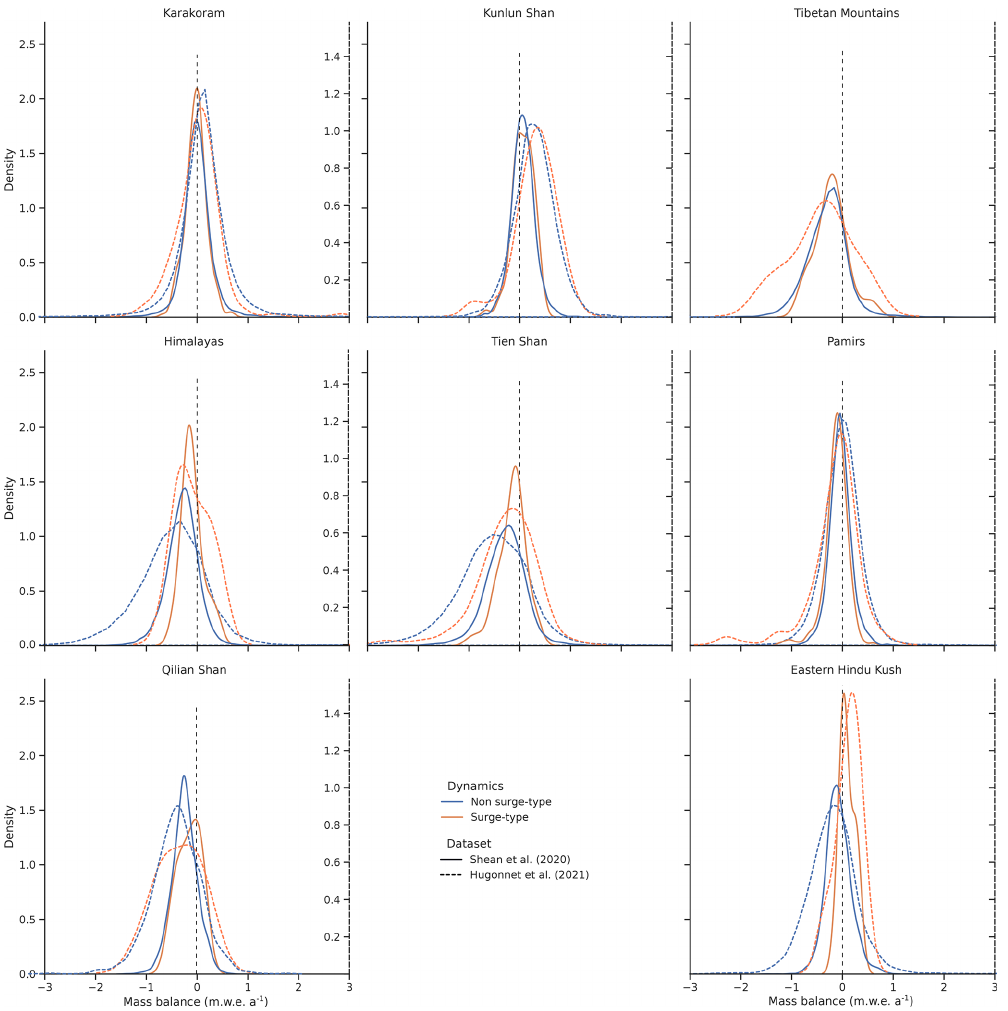
Figure 10. Distributions of mass balance for surge-type and non-surge-type glaciers for the greater HIMAP regions derived from the results of Shean et al. (2020) and Hugonnet et al. (2021). Strong differences are noticeable in regions where sample sizes are low (Himalayas, Qilian Shan, Hindu Kush, etc.). Comparisons between mass balance patterns of surge-type and non-surge-type glaciers are however difficult given the overall uncertainty associated with surface elevation change datasets.